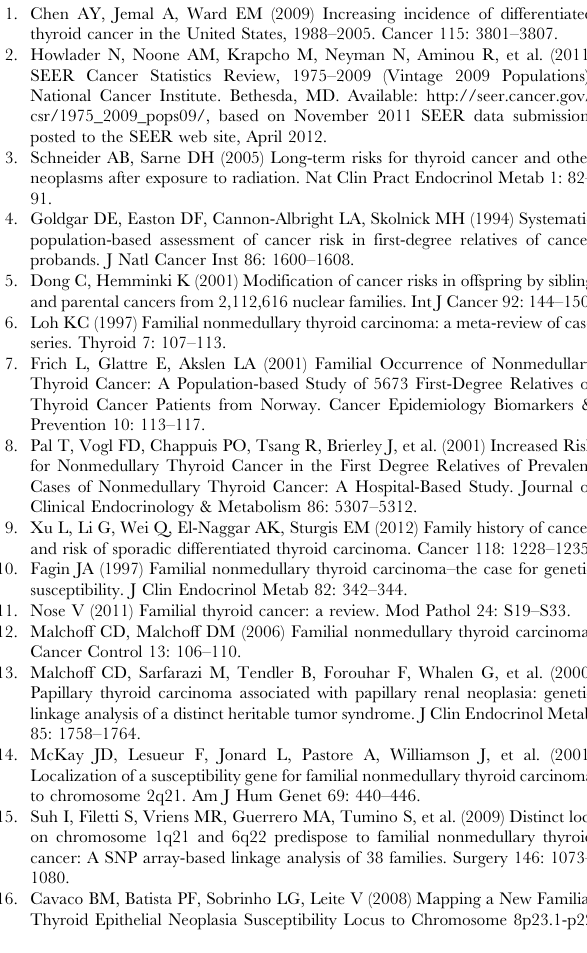
Table S1 Alignment result with Enhancer Element Locator program in the 4q32A . C region. Table S2 Primers used for sequencing, SNaPshot assay, RT-PCR, and ChIP